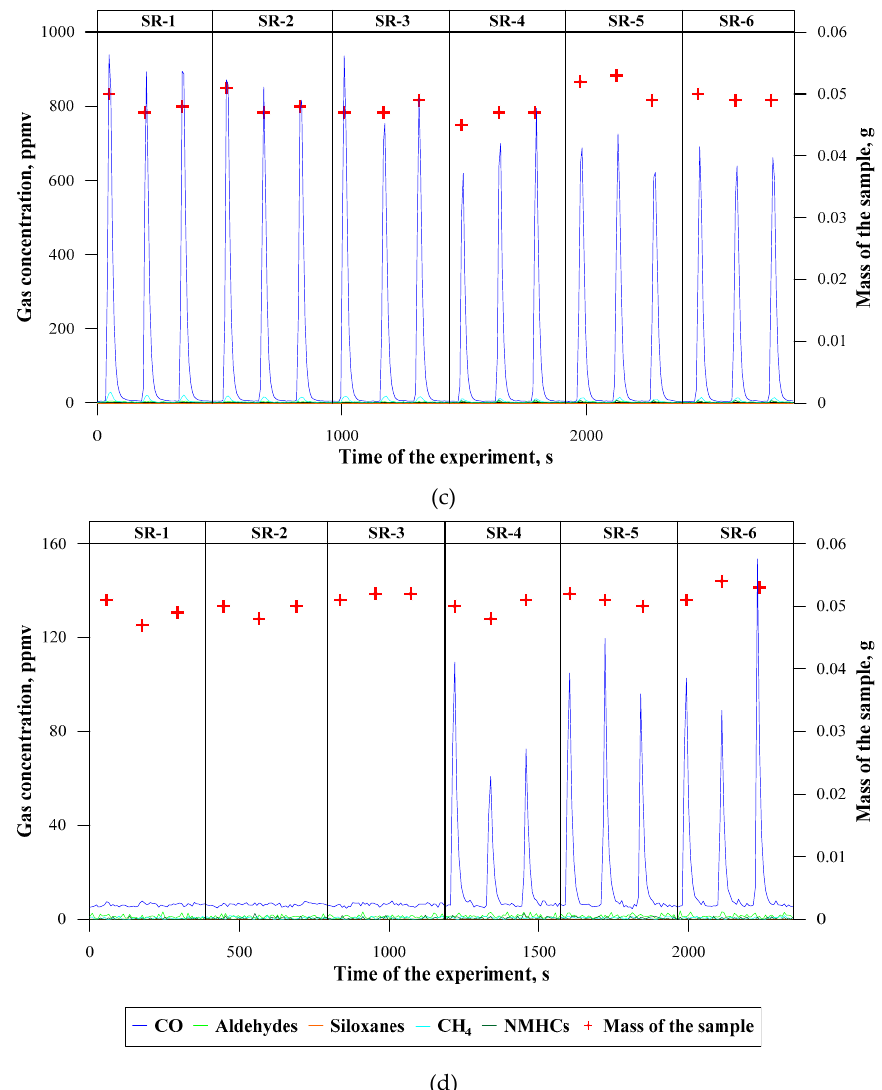
Figure 3. Concentrations of the main toxic products emitted during thermal decomposition of silicon rubber composites: ( a ) at 500 °C; ( b ) at 600 °C; ( c ) at 700 °C; and, ( d ) at 800 °C.